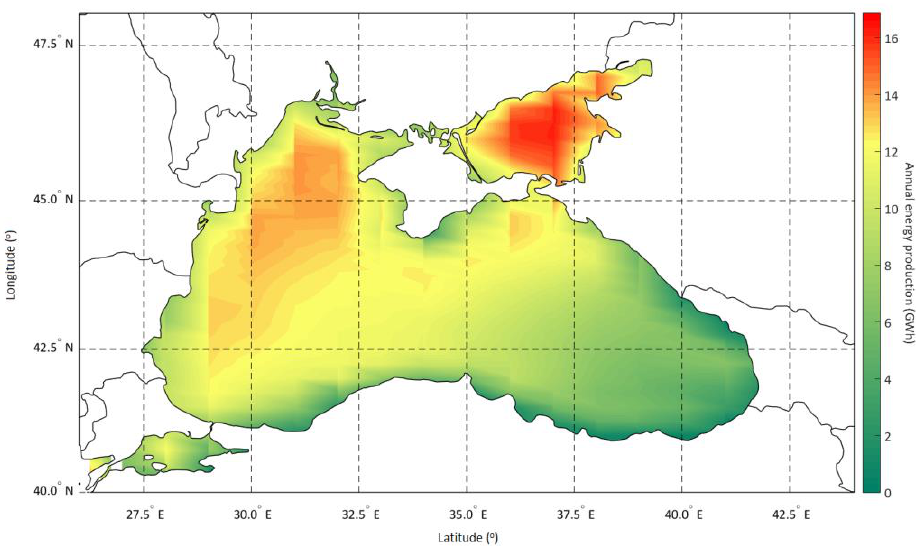
Figure 10. Airborne 5 MW—annual energy production (in GWh) expected for the U200 wind conditions.